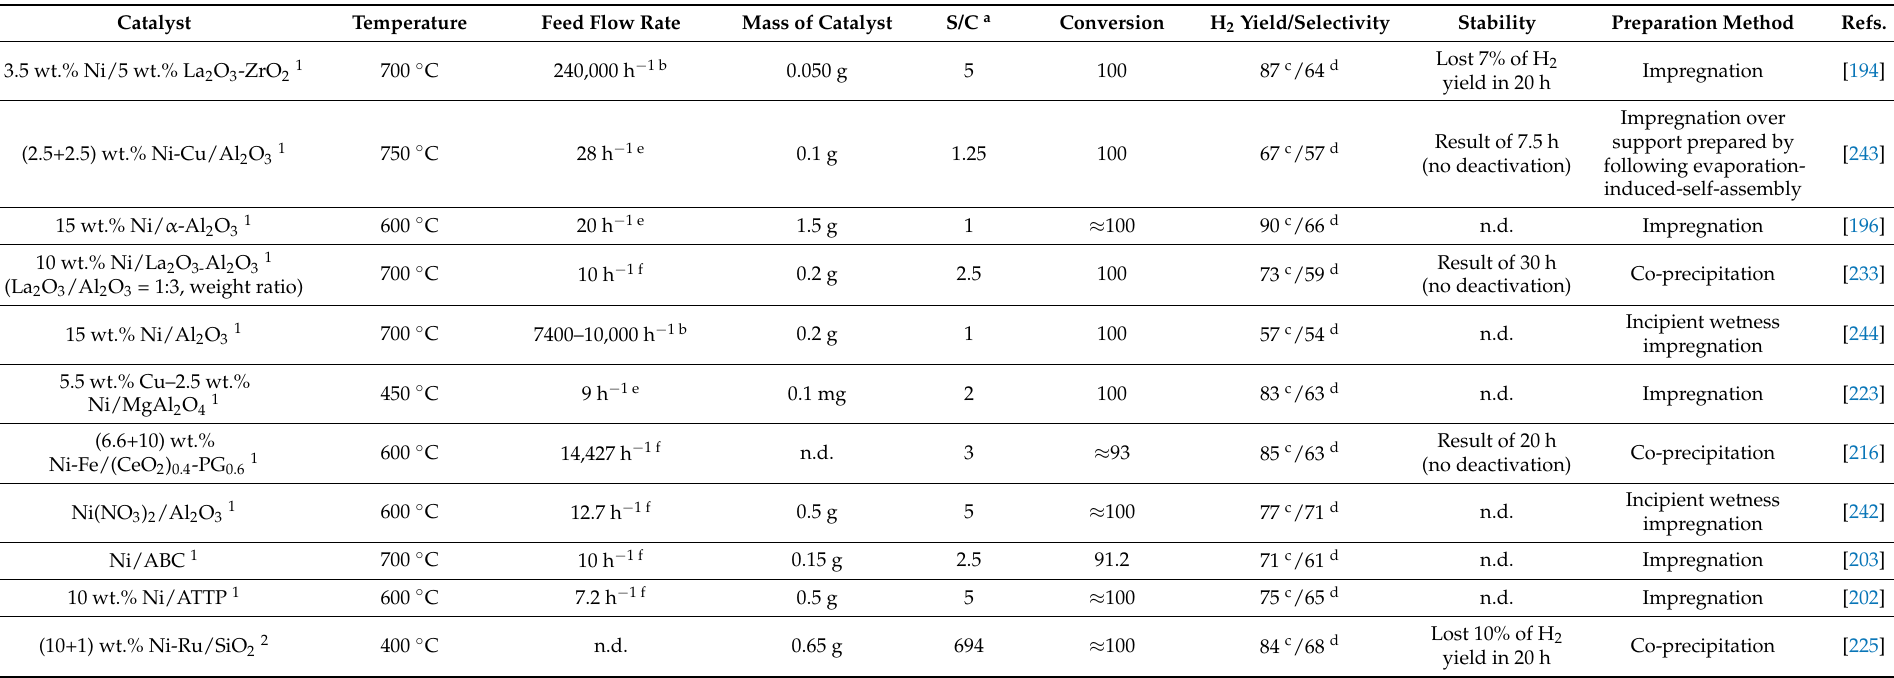
Table 6. Comparison of some of the most promising OSR catalysts reviewed in this